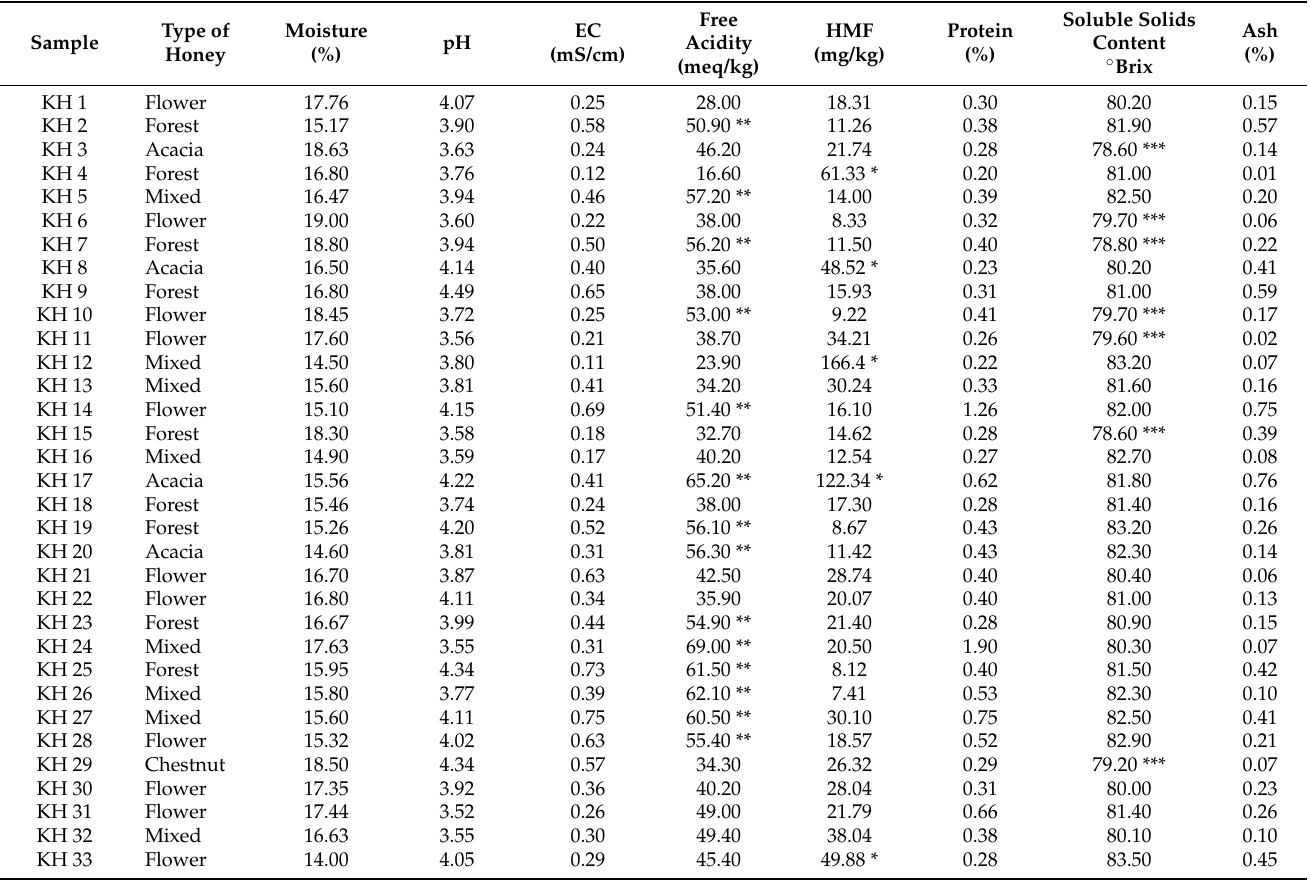
Table 2. Physicochemical parameters of Kosovo’s honey samples